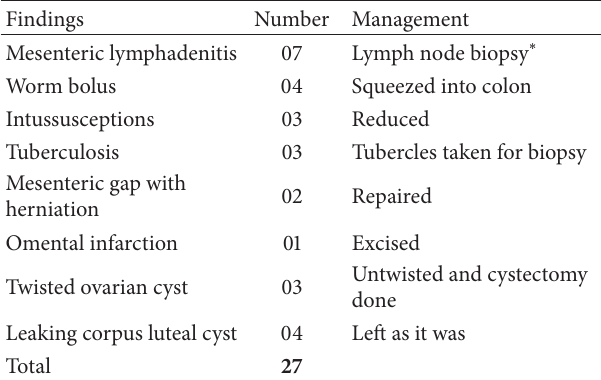
Table 1: Extra-appendicular pathologies found at laparoscopy †